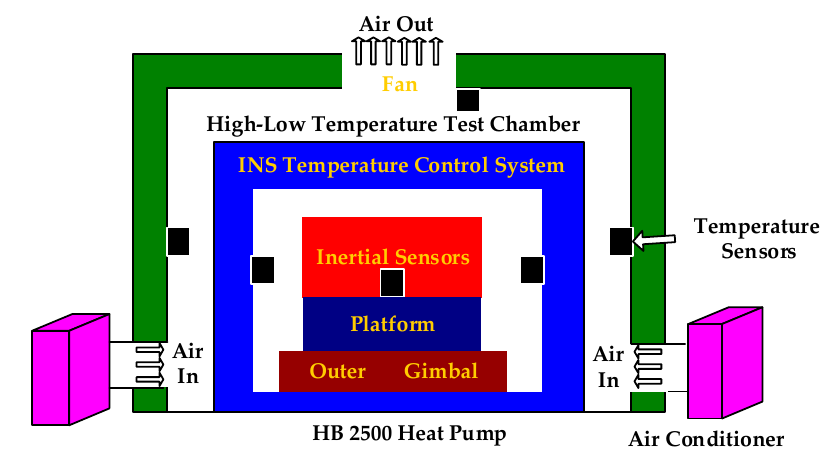
Figure 3. Configuration of the evaluation system.